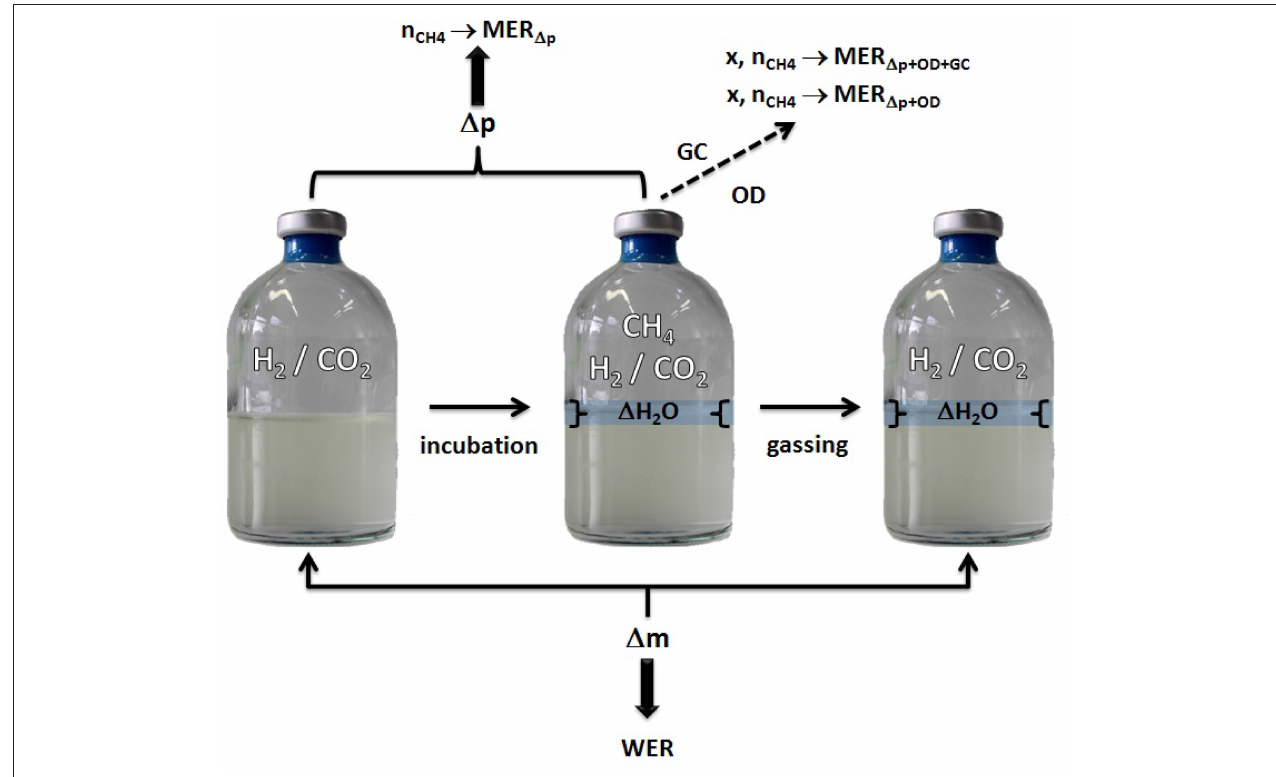
FIGURE 6 | Model for WER and MER determination using serum bottle headspace pressure and 1 water mass quantification.